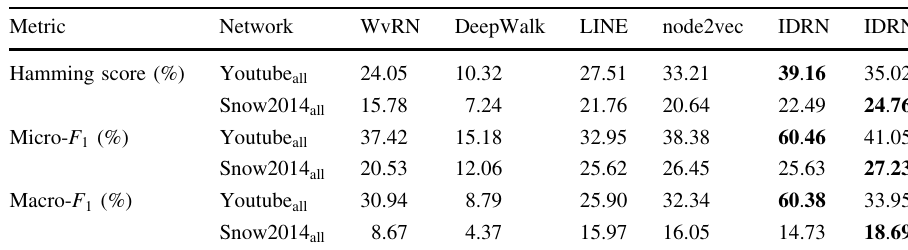
Table 6 Experiment comparisons of baselines, IDRN and IDRN c by the metrics of Hamming score, Micro (cid:4) F 1 score and Macro (cid:4) F 1 score with 10% labeled nodes for training in partially labeled